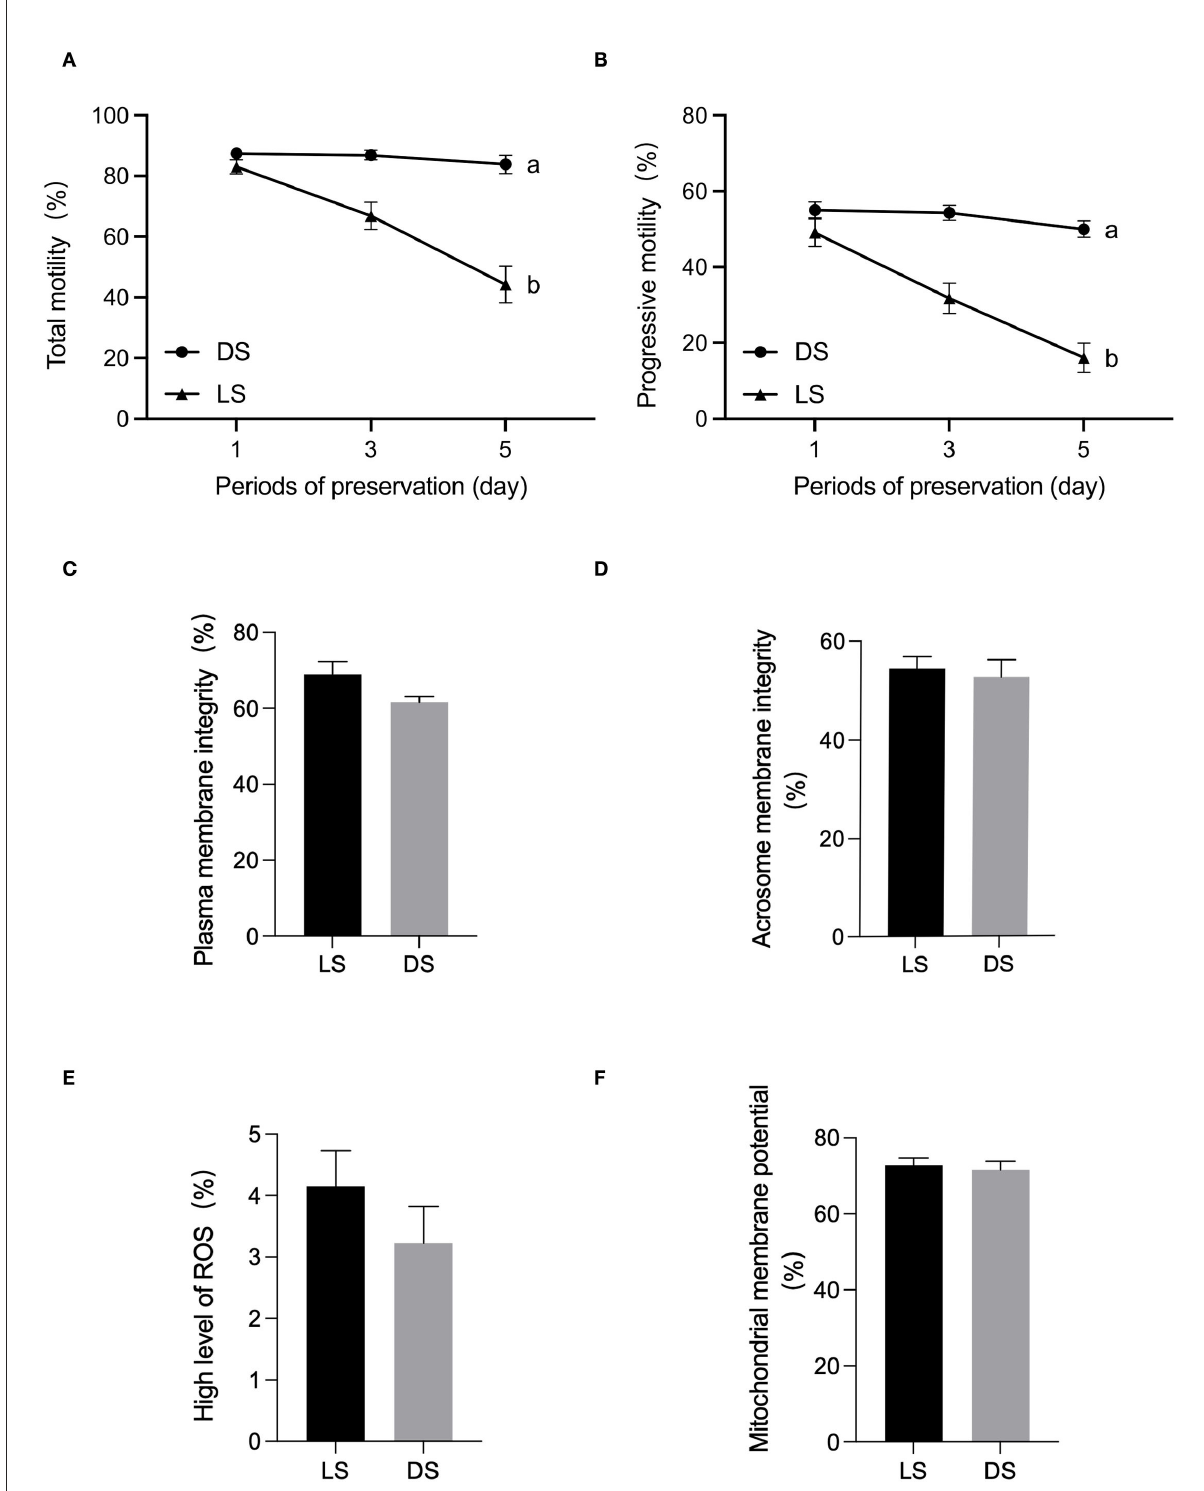
FIGURE1 Assessment of semen quality parameters between Duroc and Liang guang Small-spotted pig. (A) Sperm total motility parameter was evaluated at days 1, 3, and 5 of semen preservation, respectively, (B) sperm progressive motility, (C) plasma membrane integrity, (D) acrosomal membrane integrity, (E) reactive oxygen species, and (F) mitochondrial membrane potential were assessed on day 1. Date are presented as the mean ± SEM, and different letters indicate significant differences; unmarked means the difference is not